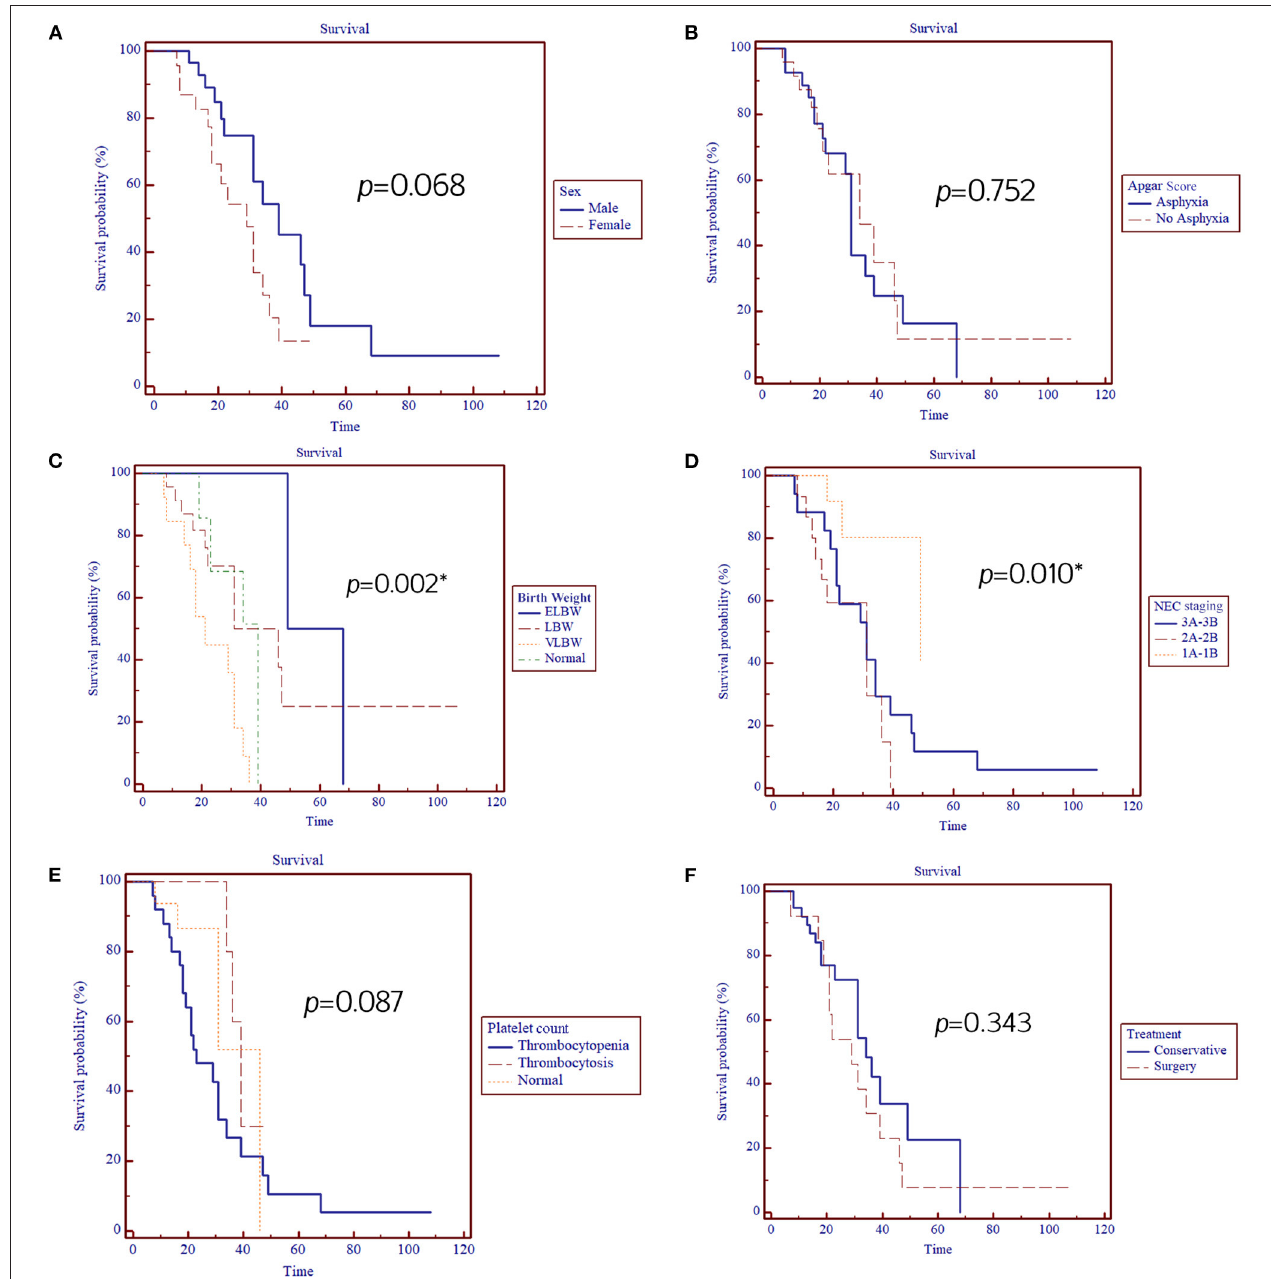
FIGURE 1 | Kaplan–Meier analysis for the association between prognostic factors: (A) Sex, (B) APGAR score, (C) Birth weight, (D) NEC staging, (E) Platelet count, (F) Treatment, and NEC patients’ survival. *, significant p <